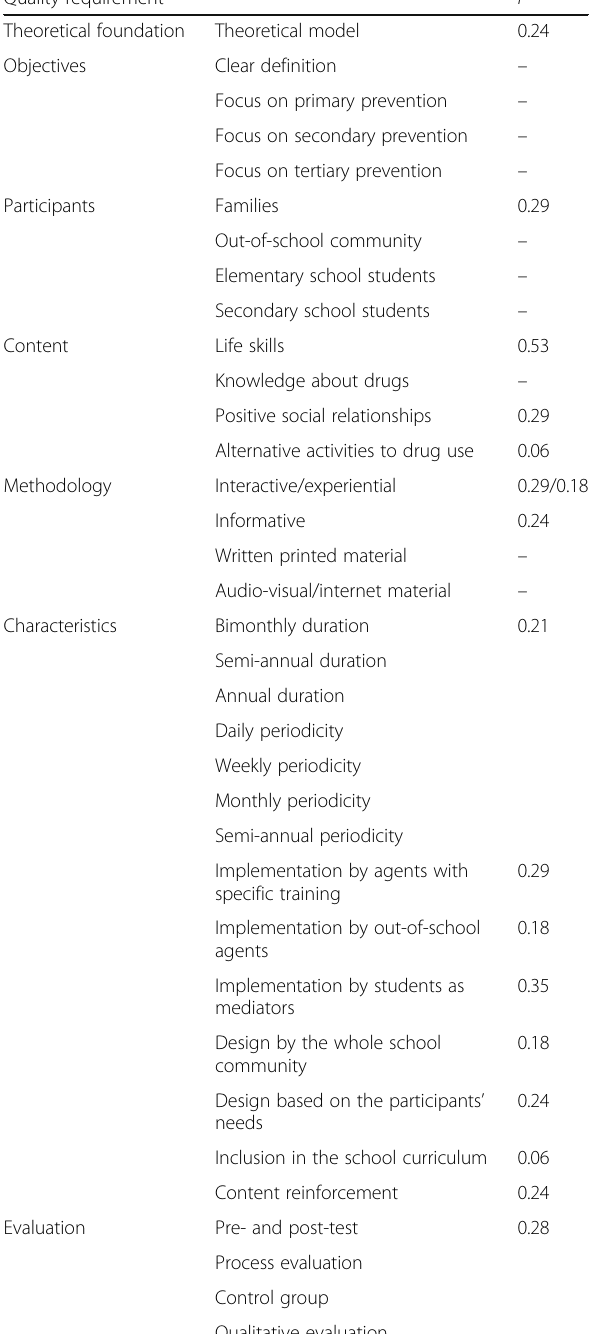
Table 2 Checklist of project quality requirements with strength- of-evidence of effectiveness of the essential effectiveness elements ( I